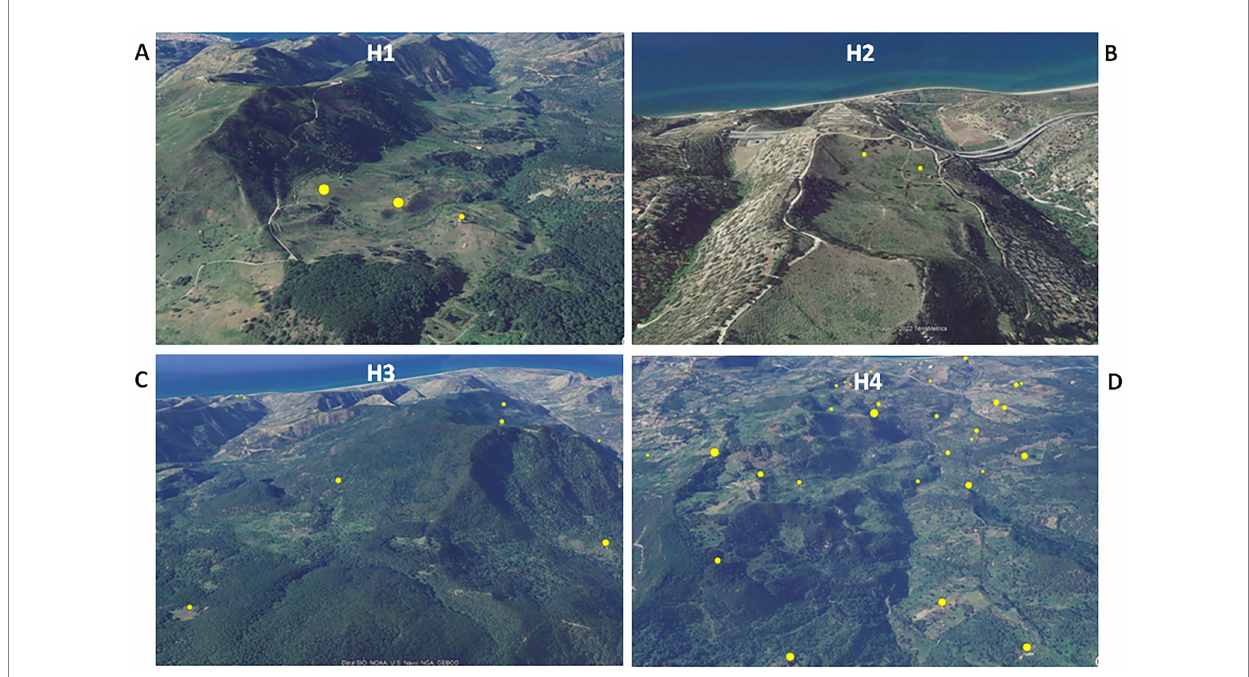
FIGURE 3 Satellite pictures of subareas H1–H4 (A–D) . Infected herds are shown as yellow dots the size of which is proportional to the number of infected animals per herd. The maps were adapted from QGis.